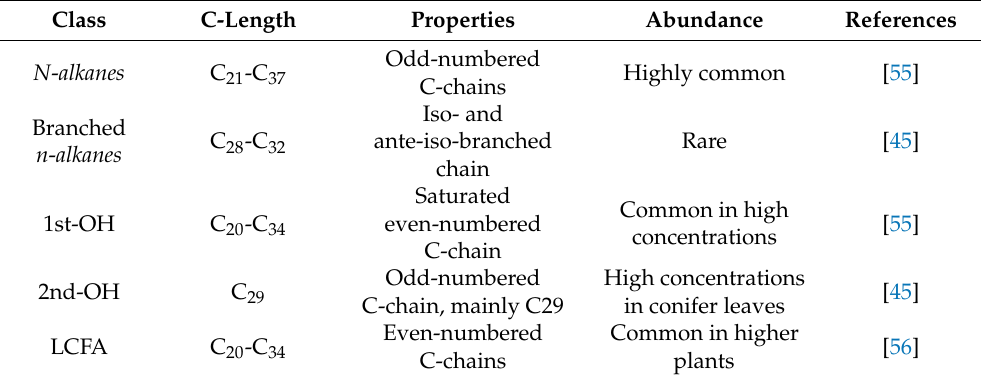
Table 1. Main properties of plant cuticular wax compounds used as biomarkers in animal nutrition